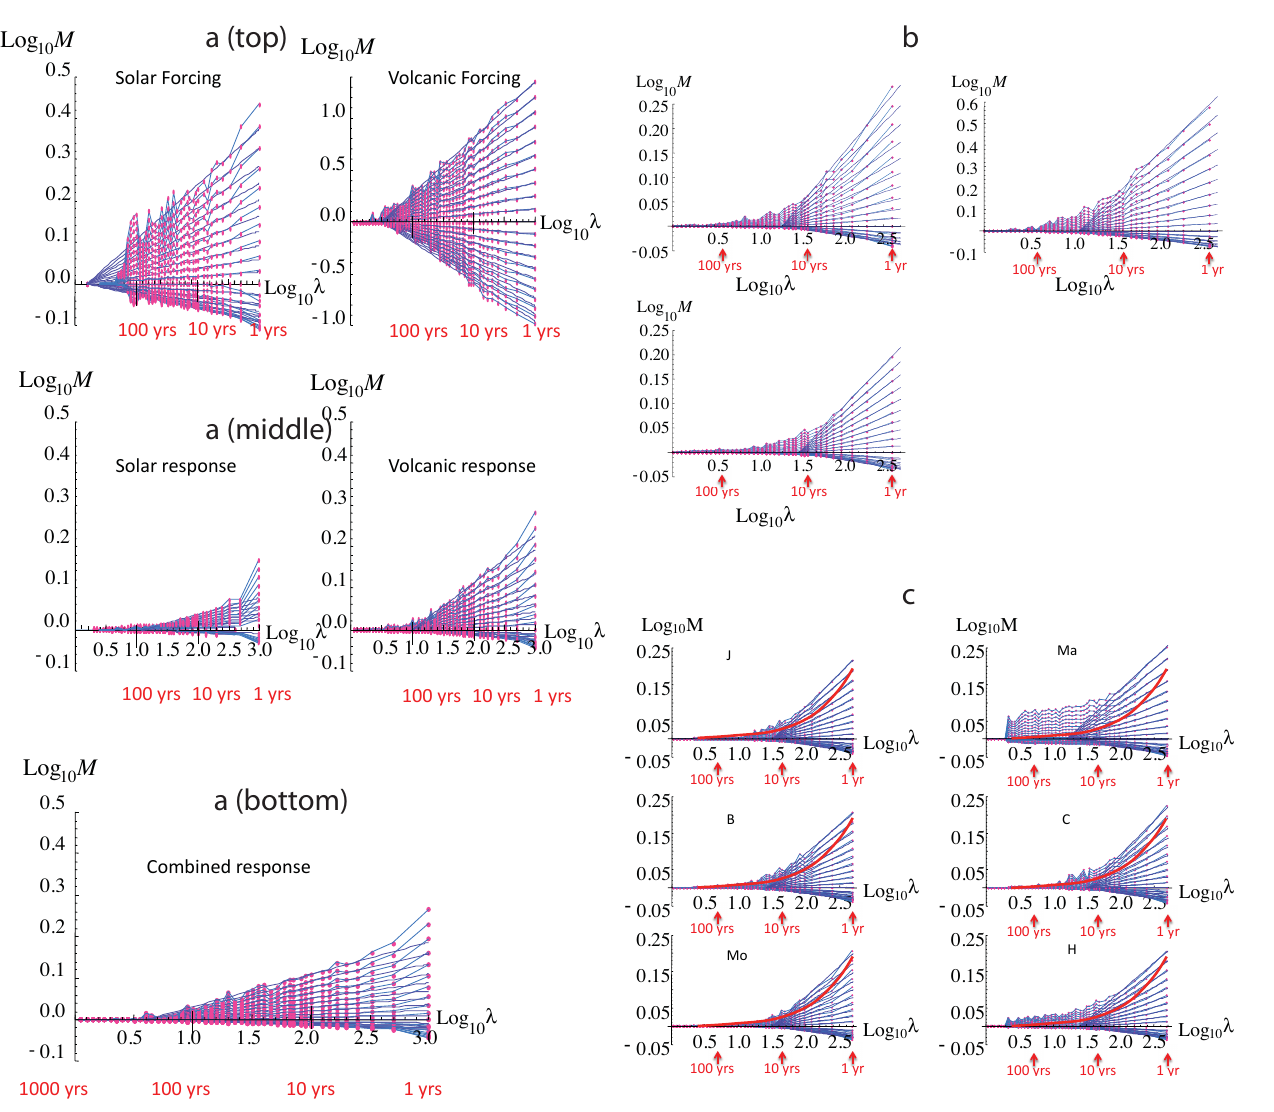
Figure 6. (a) Analysis of the flux/cascade structures of the ZC forcings (top row) and ZC temperature responses (middle, bottom rows); the normalized trace moments (Eq. 11) are plotted for q = 2, 1.9, 1.8, 1.7, 1.6, ... 0.1. Upper left is solar forcing (last 400 years only, mostly sunspot-based), upper right is volcanic, middle left is solar response (last 400 years), and middle right (volcanic response) and lower left are response to combined forcings (last 1000 years). Note that all axes are the same except for volcanic. For solar, only the last 400 years were used since this was reconstructed using the more reliable sunspot-based method. The earlier 10 Be-based reconstruction had relatively poor resolution and is not shown. Since the volcanic variability was so dominant, for the combined response (bottom left) the entire series was used. The red points and lines are the empirical values, and the blue lines are regressions constrained to go through a single outer scale point (see Eq. 11). In comparing the different parts of the figure, note in particular (i) the log–log linearity for different statistical moments, (ii) the fact that the lines for different moments reasonably cross at a single outer scale, and (iii) the overall amplitude of the fluctuations – for example by visually comparing the range of the q = 2 moments (the top series) as we move from one graph to another. (b) The above shows the responses for the GISS-E2-R simulations (Northern Hemisphere, land, 1500–1900); λ = 1 corresponds to 400 years. The upper left is for the response to the Crowley reconstructed volcanic forcings (same as used in the ZC simulations, not the change in the vertical scale), the upper right for the Gao reconstructed volcanic forcings and the lower left is for the solar-only forcing (mostly sunspot-based, same as used in the ZC simulations). (c) Trace moment analysis of six annual resolution multiproxies, J: Jones; Ma: Mann 98; B: Briffa; C: Crowley; Mo: Moberg; H: Huang. The curves are reproduced, with permission, from Fig. 11.8 of Lovejoy and Schertzer (2013), where